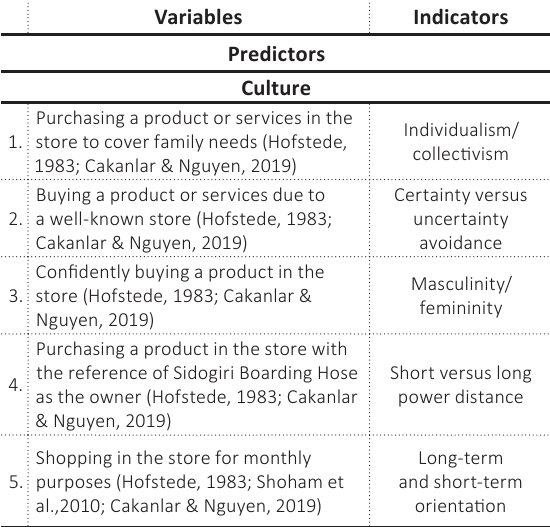
Table 1. Definition of operational